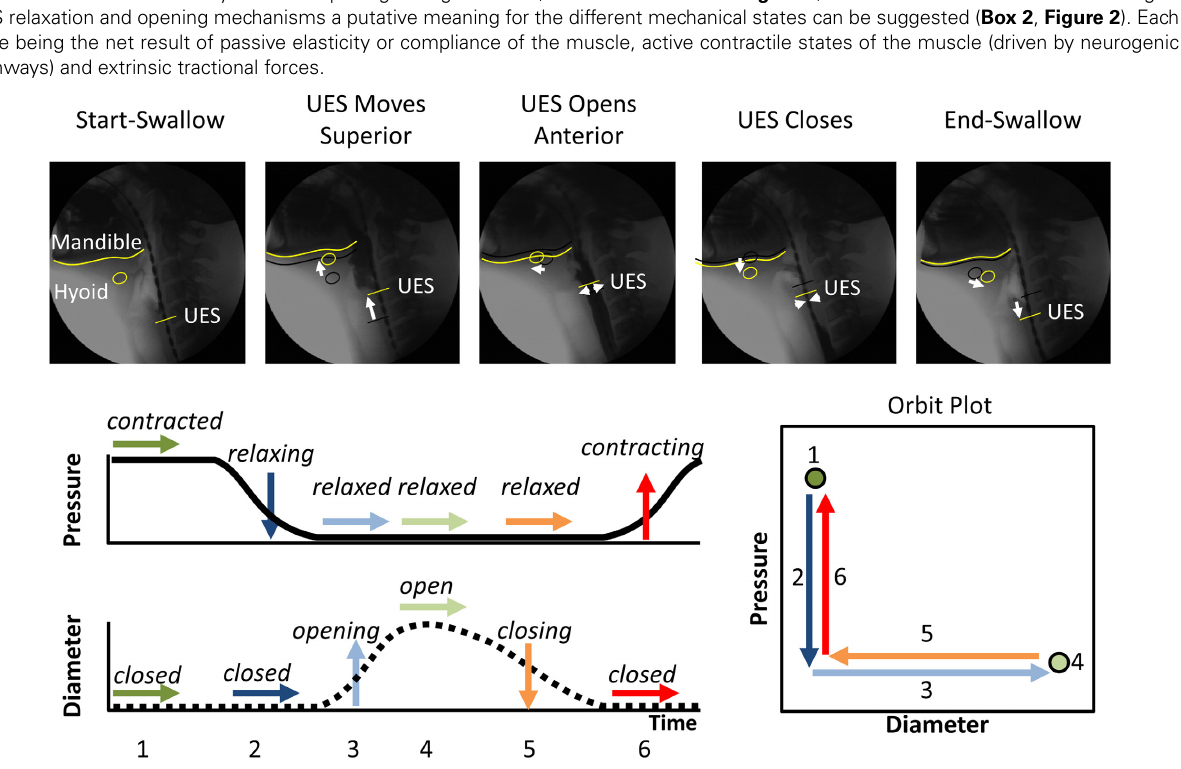
indicating periods when the diameter is static ( → ), increasing ( ↑ ) or decreasing ( ↓ ). When the pressure and diameter data are interpreted together, different mechanical states can be defined based on the direction of pressure change and in relation to whether the lumen is open, closed or changing in diameter. The relationship of diameter vs. pressure over time can also be visualized by way of an “Orbit” plot. The mechanical states numbered 1–6 typify the normal sequence of UES contractility and UES opening during swallowing. Note: Nomenclature describing the states shown is provided in Figure 2